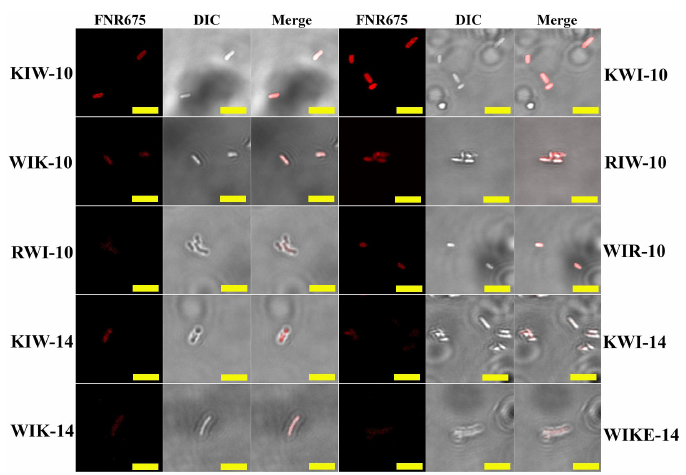
Figure 4. Cellular distributions of peptides in E. coli cells. E. coli cells incubated with Flamma675- labeld peptides at each MIC for 30 min were observed by Confocal Laser-Scanning Microscopy (CLSM). Bar = 5 µ m.